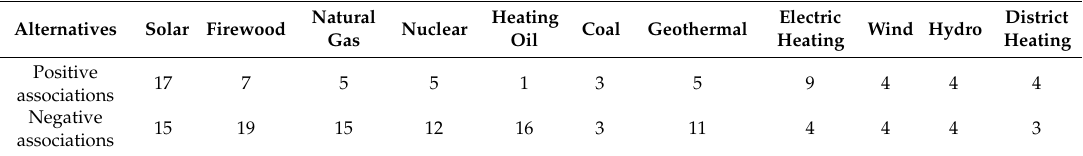
Table 3. Notions and criteria mentioned during the focus group discussions based on the report, attributed to the energy supply alternatives.